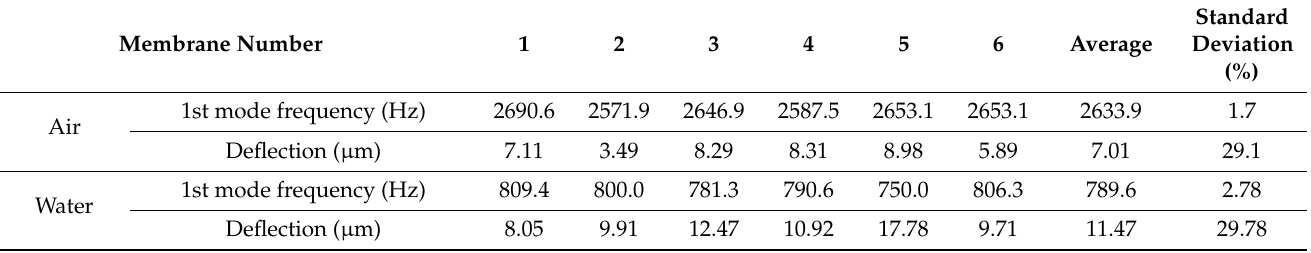
Table 1. First mode frequency and related deflection of each vibrating